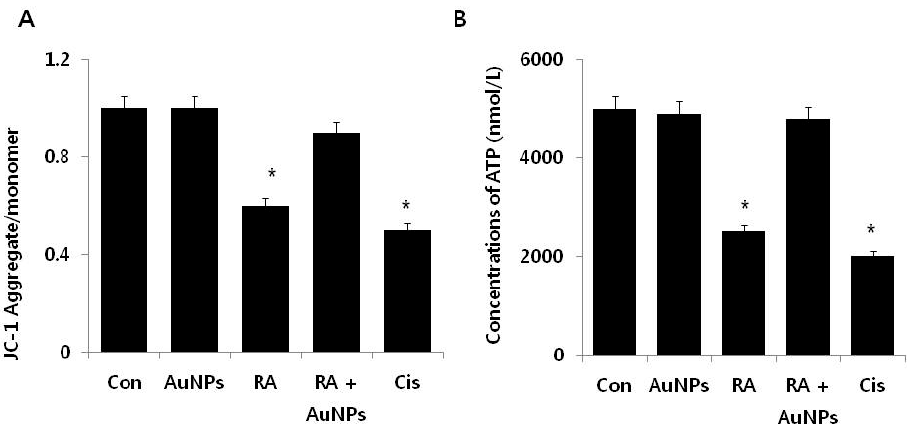
Figure 6. Effects of AuNPs on RA-induced mitochondrial dysfunction in F9 cells. ( A ) F9 cells were treated with AuNPs (10 μ M), RA (10 μ M), and RA in the presence of AuNPs (both 10 μ M) for 24 h and the MMP was determined using the cationic fluorescent indicator JC-1; ( B ) ATP level was measured in F9 cells exposed to AuNPs (10 μ M), RA (10 μ M), and RA in the presence of AuNPs (both 10 μ M).